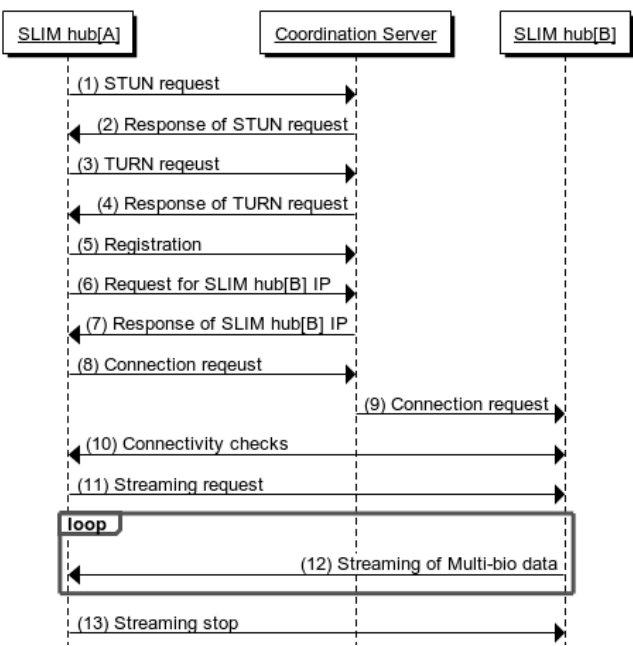
Figure 13. Sequence diagram of SLIM hubs in other private network. Figure 14. Sequence diagram of streaming service between PAAR band and SLIM